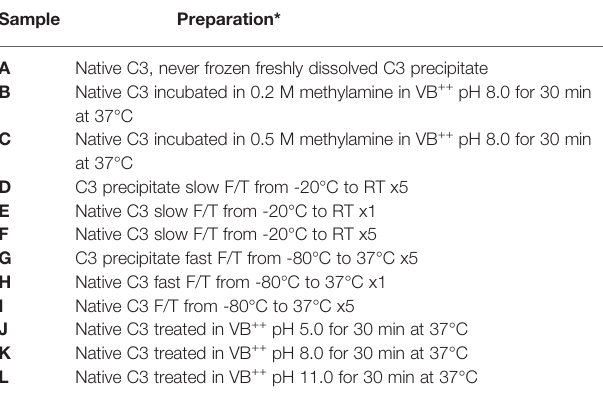
TABLE 1 | Preparations of the different pure C3 samples analyzed by cation exchange chromatography.